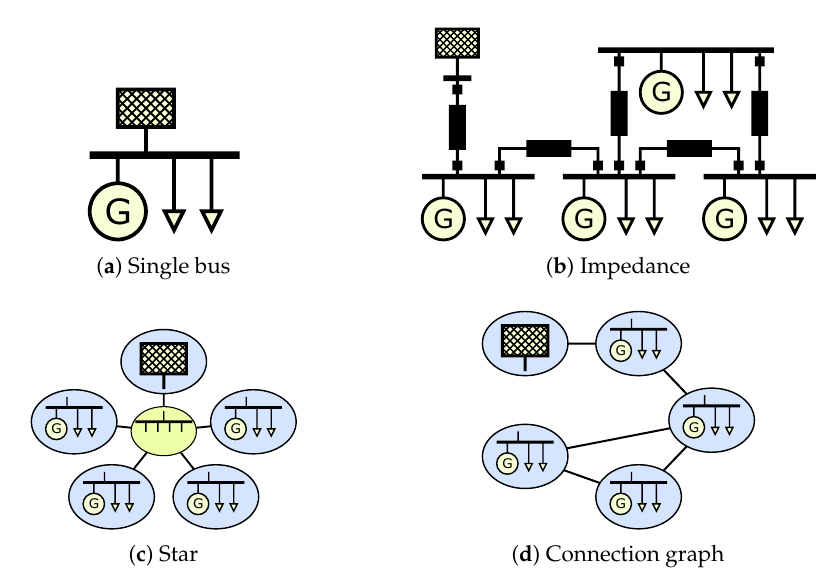
Figure 6. Observed types of grid